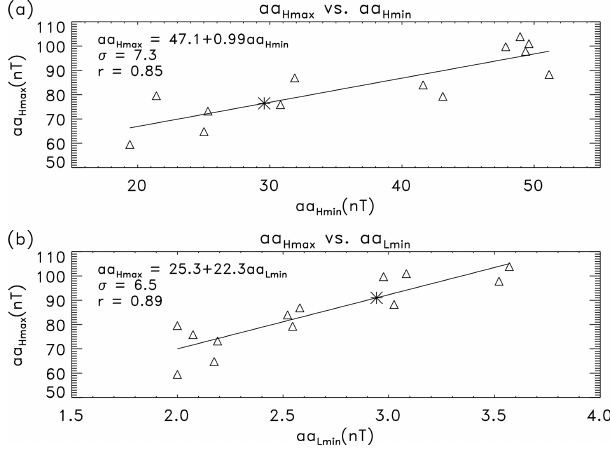
Figure 3. Scatter plots of aa H tions given